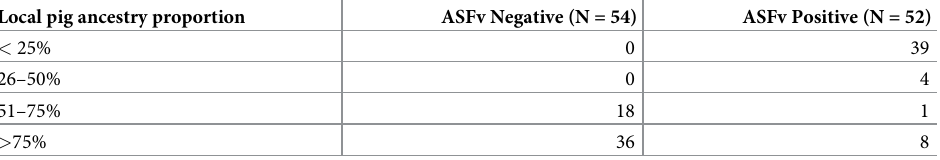
ASFv–African swine fever virus; LS Mean–Least squares mean; Min–Minimum; Max–Maximum;